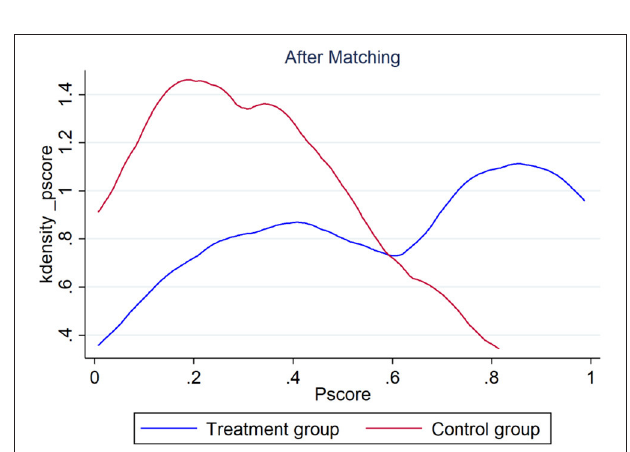
FIGURE 6 | Kernel density distribution of the propensity score after